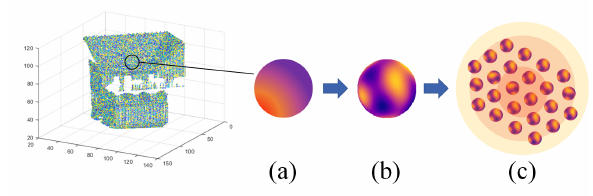
Figure 2. RIDF descriptor. (a) An individual gradient vector is represented by a distribution in sphere. (b) Signals on sphere are reconstructed from spherical harmonics. (c) Regional convolution obtained by spherical tensor operations considering the corresponding